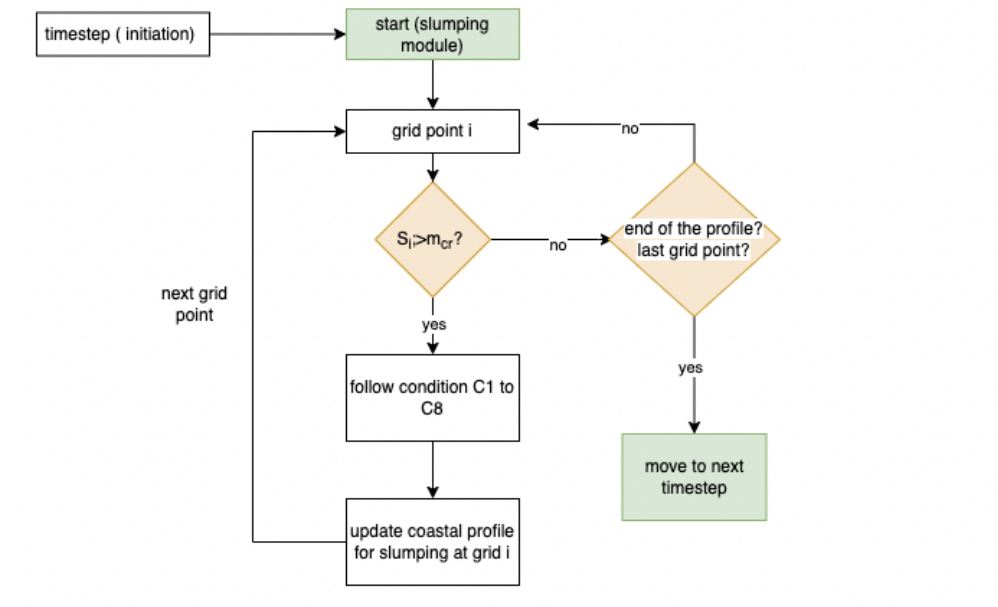
Figure A2. Workflow of the slumping